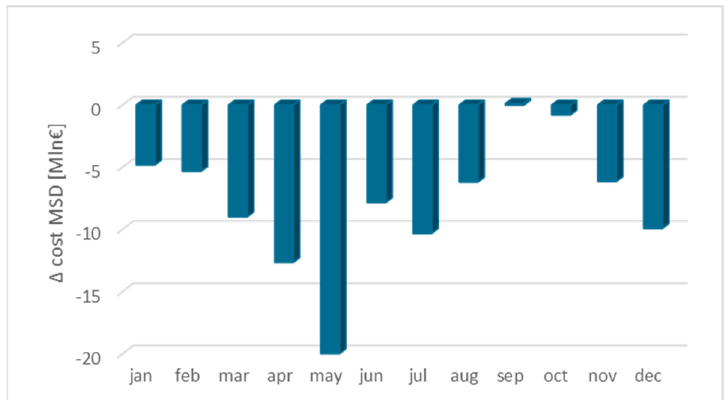
Figure 14. Monthly MSD cost increase when the RR auction is in place.